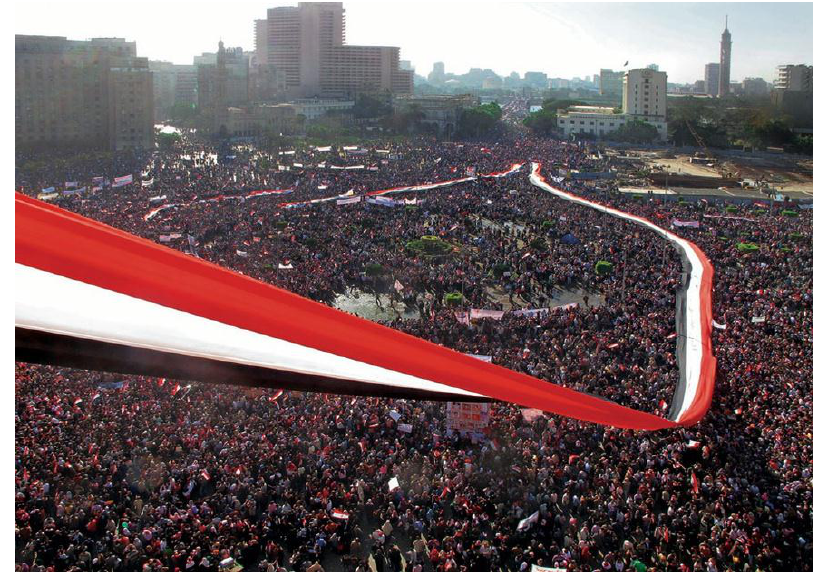
Figure 1. Lara Baladi, Tahrir Square, February 2011, used with permission from the artist. Taking place during military action to clear a planned sit-in almost a year following the widely publicized 18-days of the revolution, the violent incident that led to the “girl with the blue bra” image was captured by an independent photographer from a distanced elevated viewpoint in Cairo’s Tahrir Square on 17 December 2011. 12 The horror of the scene unfolds as swarms of security officers rush down an unidentifiable major street off of Tahrir Square toward a group of three protesters trying to flee the area. In their attempt to break free, the two male protesters are seen pulling the female along when club-yielding security forces descend upon on them. One male manages to untether himself from the ensuing clash while officers begin swinging with ferocity their clubs as they drive the male to the ground. Although any potential editing of it cannot be verified due to the amateur source of the video, the clip released to news outlets shows fourteen seconds of the pair of protesters being separately, but repeatedly beaten and kicked before a group of four security forces hauls the female protester by her garment, or abaya , several feet as it is torn open and eventually pulled over her head revealing her blue brassiere undergarment. Extracted from the video’s extended context in which the brutality against both the female and male protester is made evident, the composition of the still image is significant (Figure 2). In it, the woman appears lying on the ground (many believe that by this point, she had lost consciousness) alone, her extended arms are held by masked security officials triangulated around her. Two continue to drag her while a third will immanently lodge his boot into her